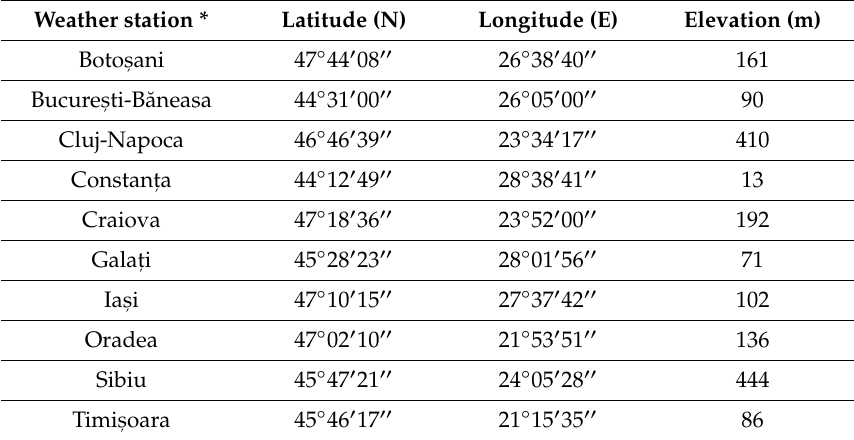
Table 1. Geographical coordinates of the weather stations considered. Weather station